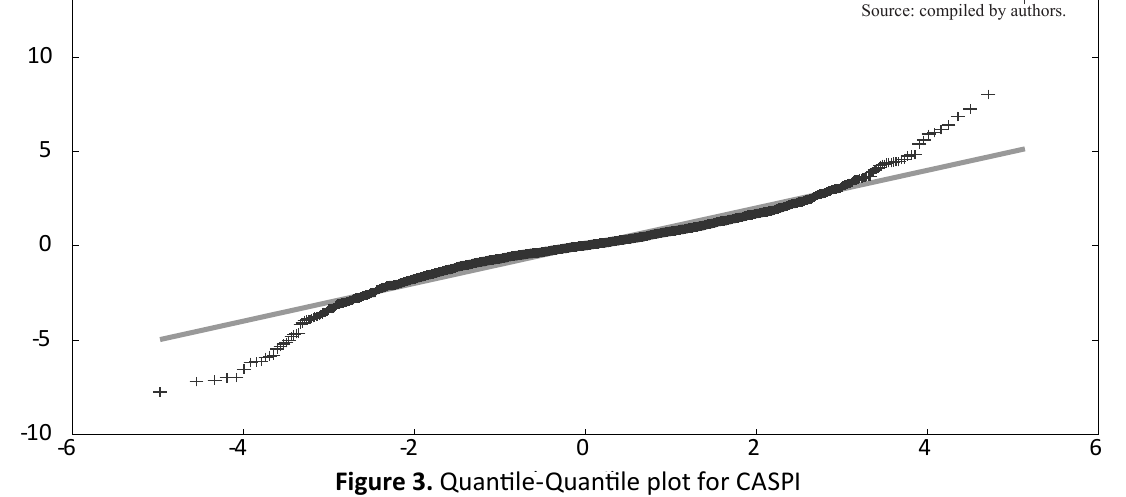
il Figure 3. Quantile-Quantile plot for